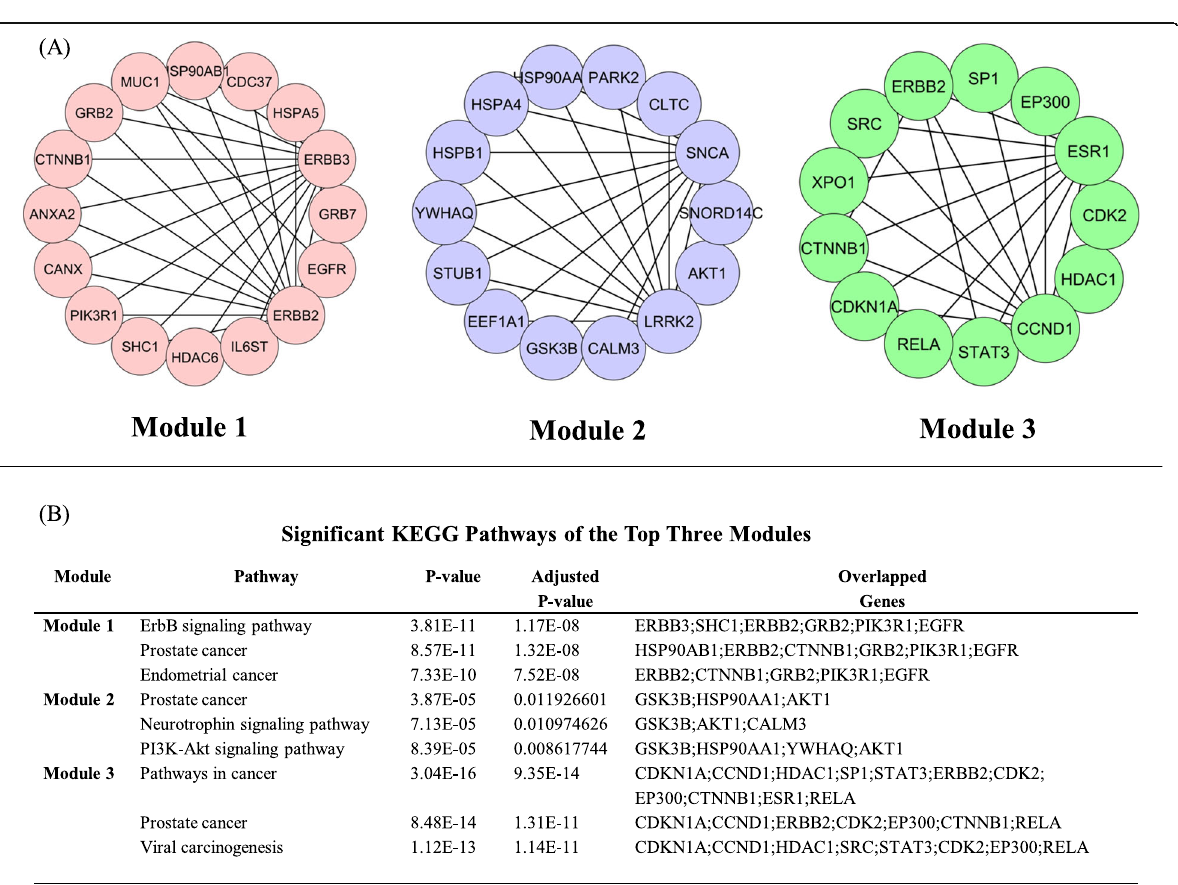
Fig. 3 a Top 3 module analysis of PPI network. b Module-associated top significant